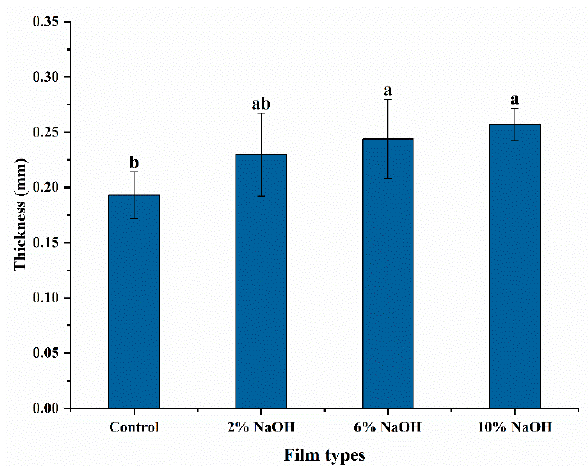
Figure 3. Thickness of HAS film after treatment with di ff erent concentrations of NaOH. Di ff erent letters in the same column represent significant di ff erences, p < 0.05.